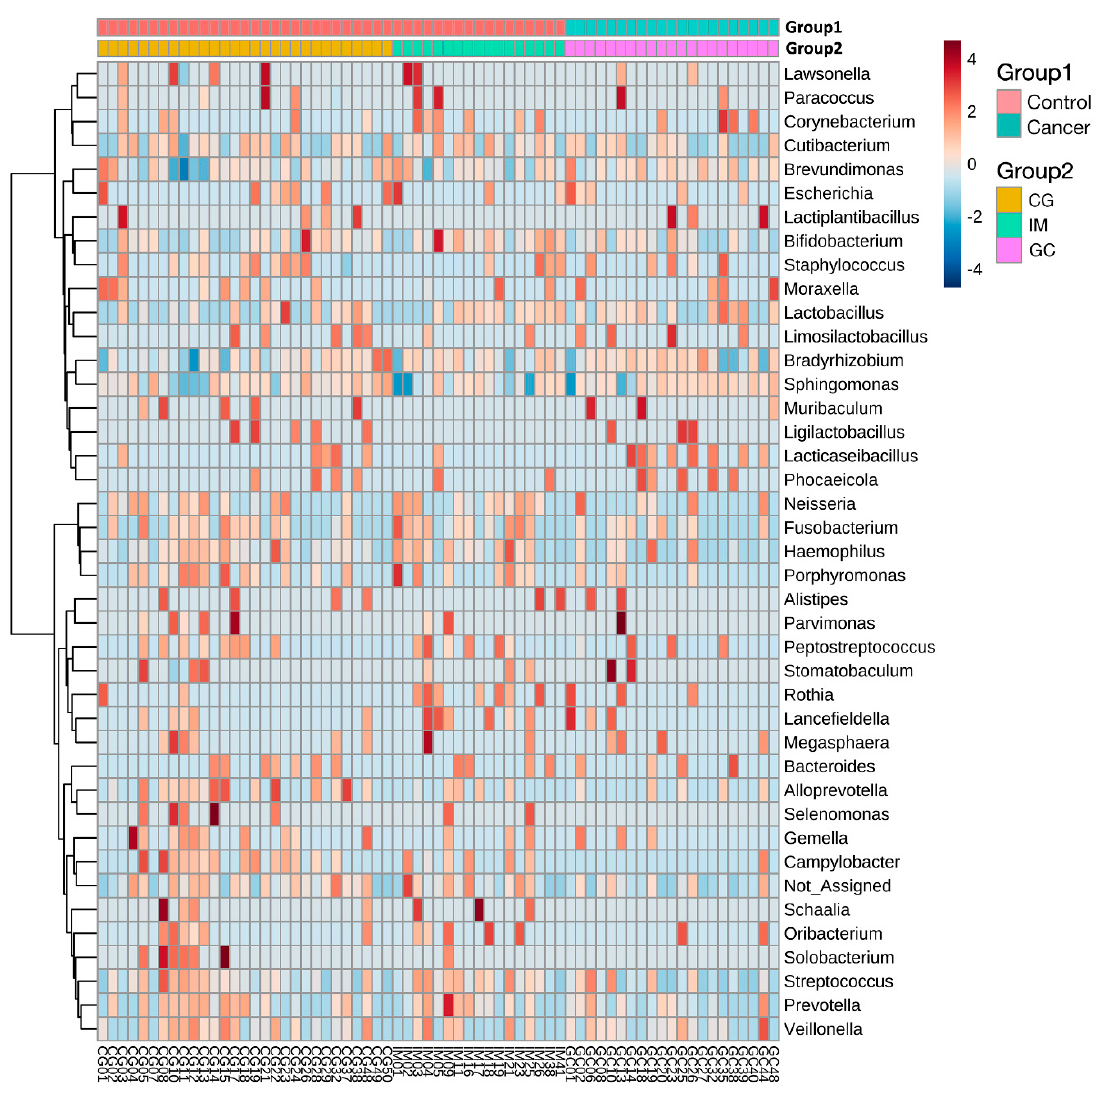
Figure 4. Hierarchical clustering heatmap for relative abundance of gastric microbiota between cancer and control groups (Group 1) at the genus level. Two-colored bars on the top of the figure show the grouping category. Every sample (control group = red, cancer group = green in Group 1) is represented by its own column. Scaling is by relative abundances of each taxon from low (light blue) to high (dark red) across all samples. Clustering was performed using Euclidean distance measure and Ward’s linkage clustering algorithm at the genus level. Individual patient identifiers are listed followed by CG, IM, or GC (Group 2), indicating chronic gastritis, intestinal metaplasia, or gastric cancer, respectively.